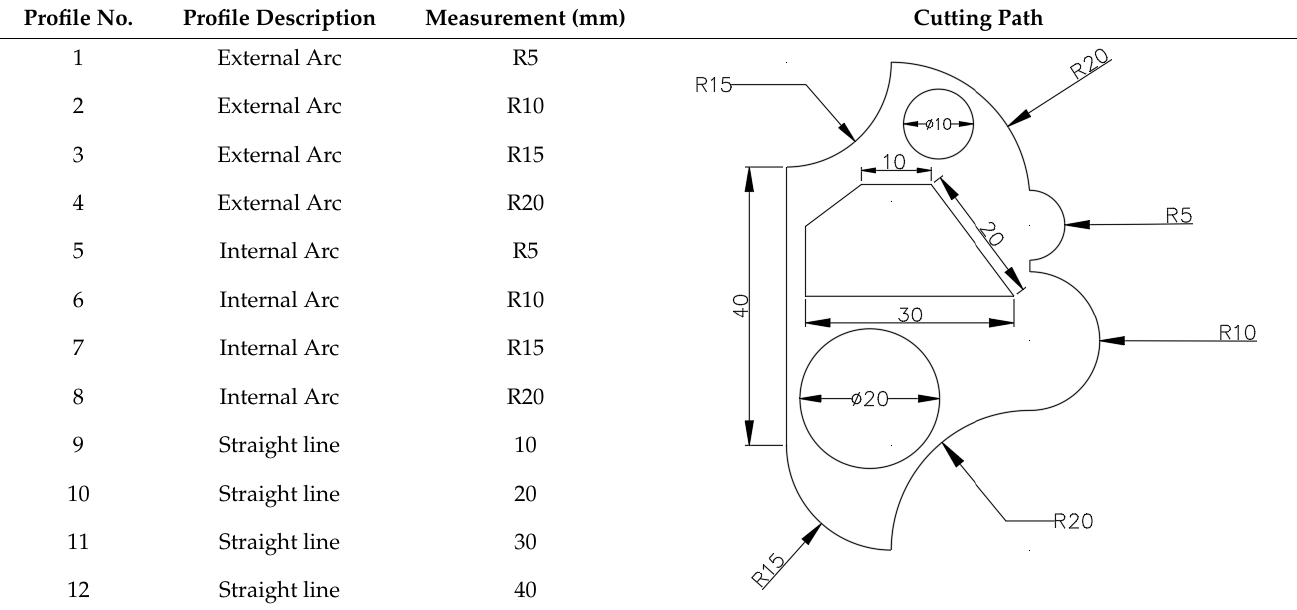
Table 4. Variable input parameters values.